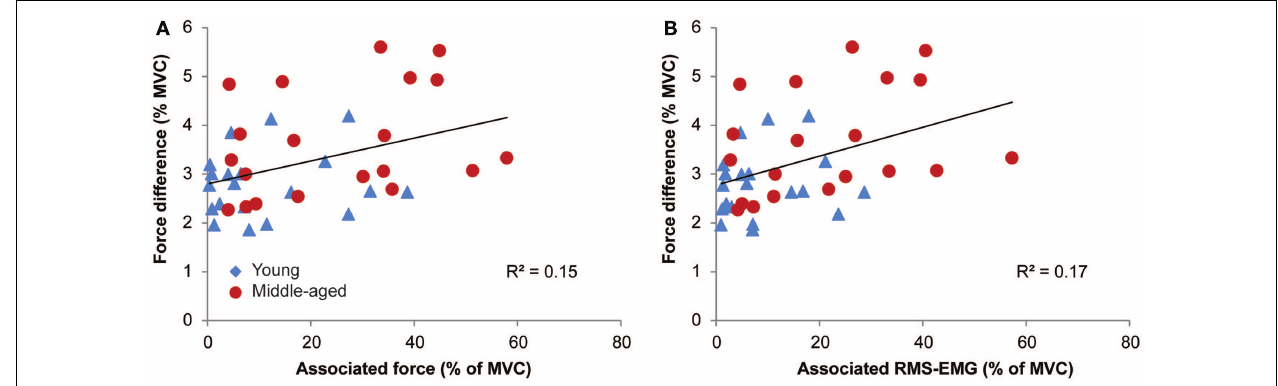
FIGURE 7 | Relationships between associated activity [EMG and force, in (A,B), respectively] and the measure of bilateral performance, i.e., force difference for young (blue triangle) and middle-aged subjects (red circles) . Participants with high levels of associated activity tended to have an inferior bilateral